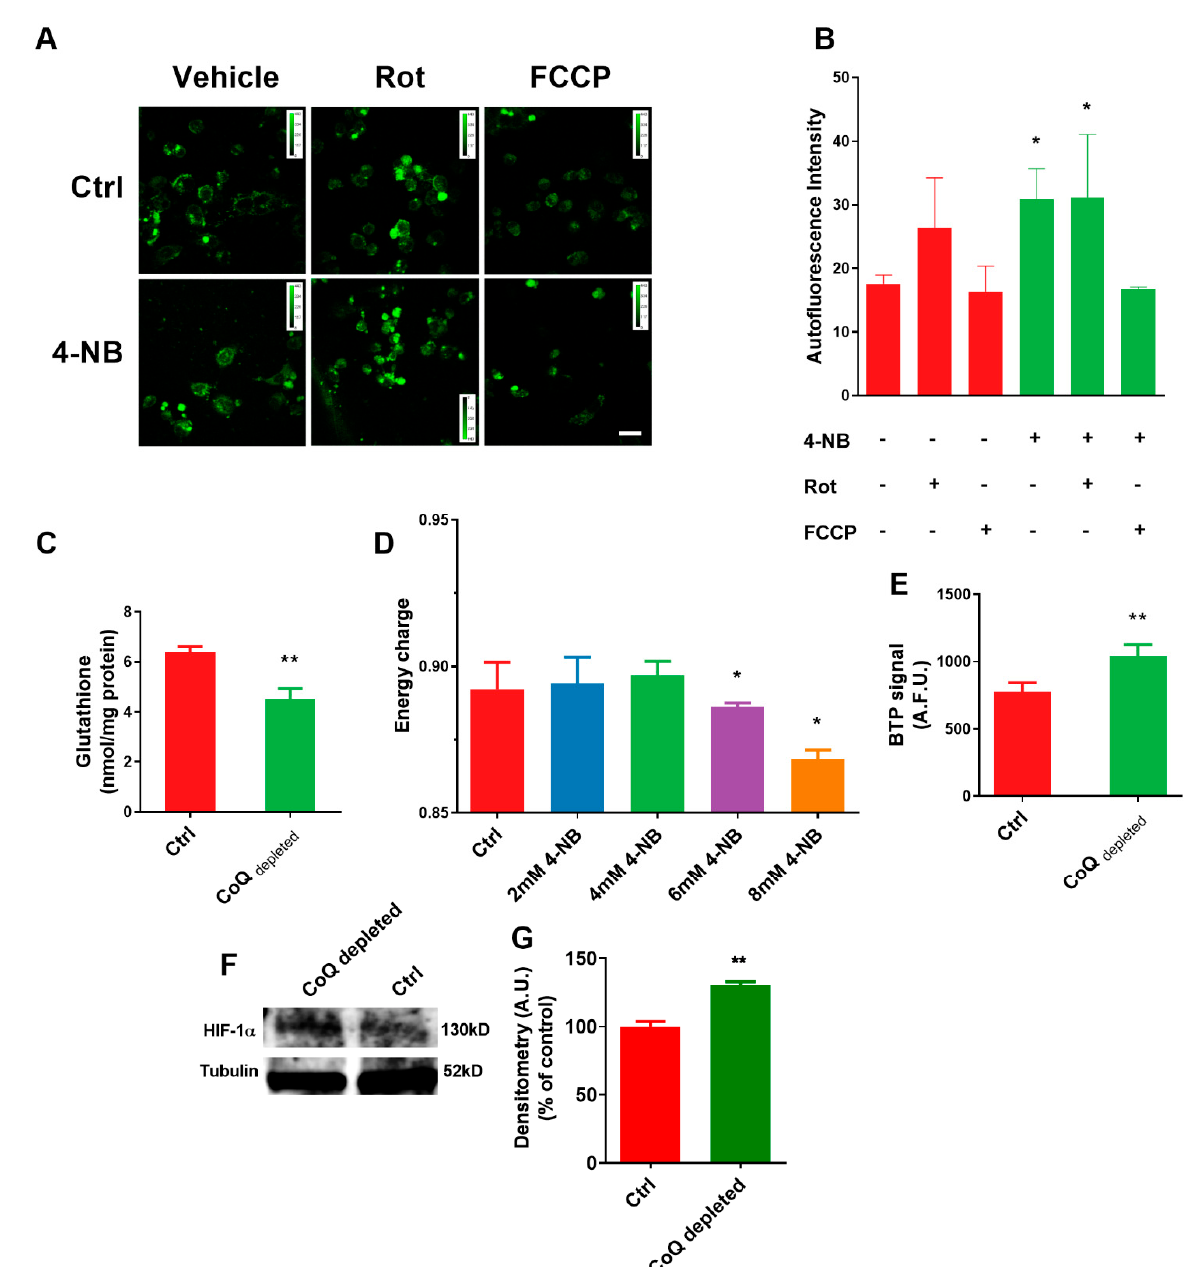
Figure 2. CoQ depletion alters redox and bioenergetic state in MCF-7 cells. MCF-7 cells were cultured in complete DMEM for 96 h in the presence of 4 mM 4-nitrobenzoic acid (4-NB) or vehicle (CTRL). ( A ) Representative micrographs and their quantifications ( B ) of NAD(P)H autofluorescence in control and 4-NB treated cells in the presence of 10 µ M Rotenone (Rot) or 10 µ M carbonyl cyanide 4-(trifluoromethoxy) phenylhydrazone (FCCP). For each condition were analyzed at least two randomly chosen fields from three independent experiments with ImageJ software. Scale bar: 70 µ m. ( C ) Determination of reduced glutathione content determination in control and 4-NB treated cells. ( D ) Cellular energy charge quantification in cells cultured for 96 h in the presence of different concentrations of 4-NB ( n = 3). ( E ) Quantification of fluorescence emission in control and 4-NB treated cells stained with the dye bis (2-(2 (cid:48) -benzothienyl)-pyridinato-N, C30) iridium (acetylacetonate) (BTP). BTP is a live-cell O 2 sensor which fluorescence emission is quenched by molecular oxygen. ( F ) HIF-1 α level in cells lysates. ( G ) Quantification of HIF-1 α performed by densitometry analysis, using tubulin as a loading control ( n = 2). Error bars indicate the standard error of the mean (SEM). Statistical analysis was performed using GraphPad Prism software. For comparison between two groups, p values were obtained using unpaired t -test with Welch’s correction. For comparison between multiple groups, p values were obtained using the analysis of variance (ANOVA) followed by Tukey’s post hoc test. * p ≤ 0.05; ** p ≤